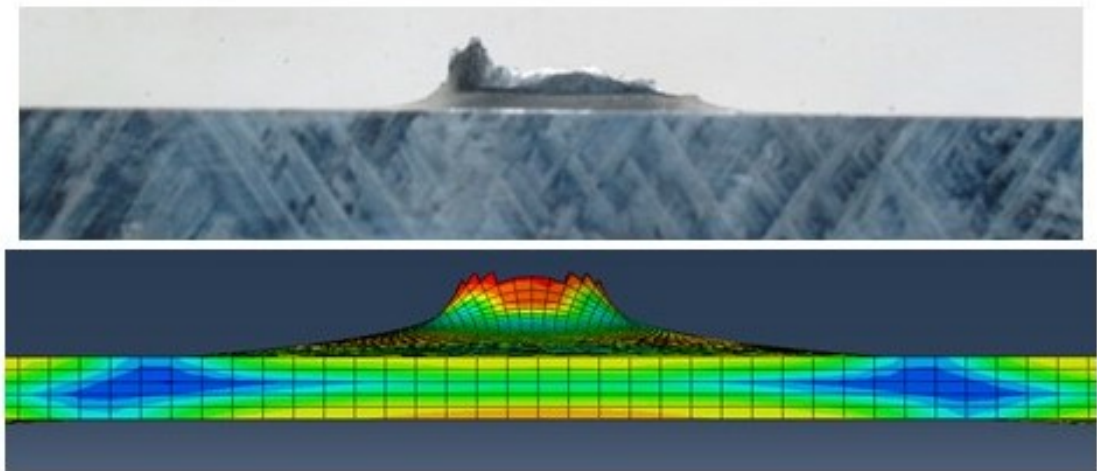
Figure 9. Visual Comparison of the Target with the Finite Element